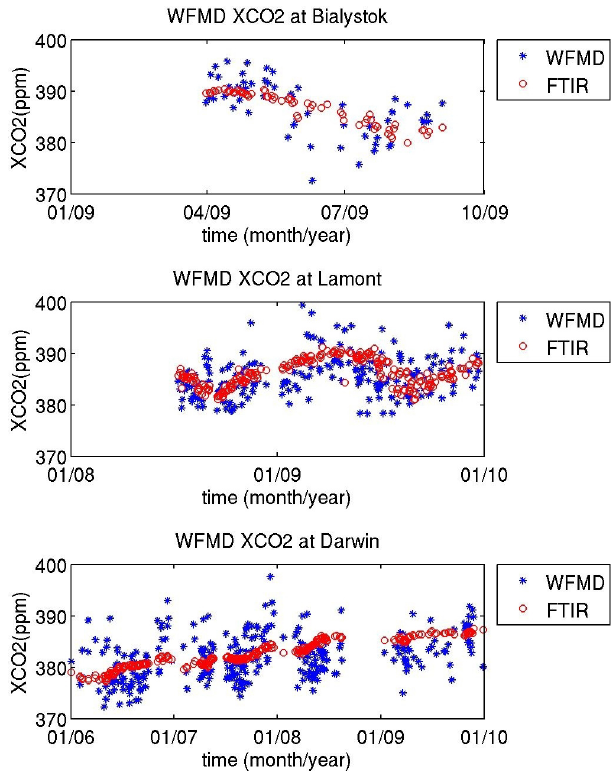
Figure 5. Daily averaged time series of paired WFMD and TCCON FTIR XCO 2 at Bialystok (top), Lamont (mid) and Darwin (bottom).